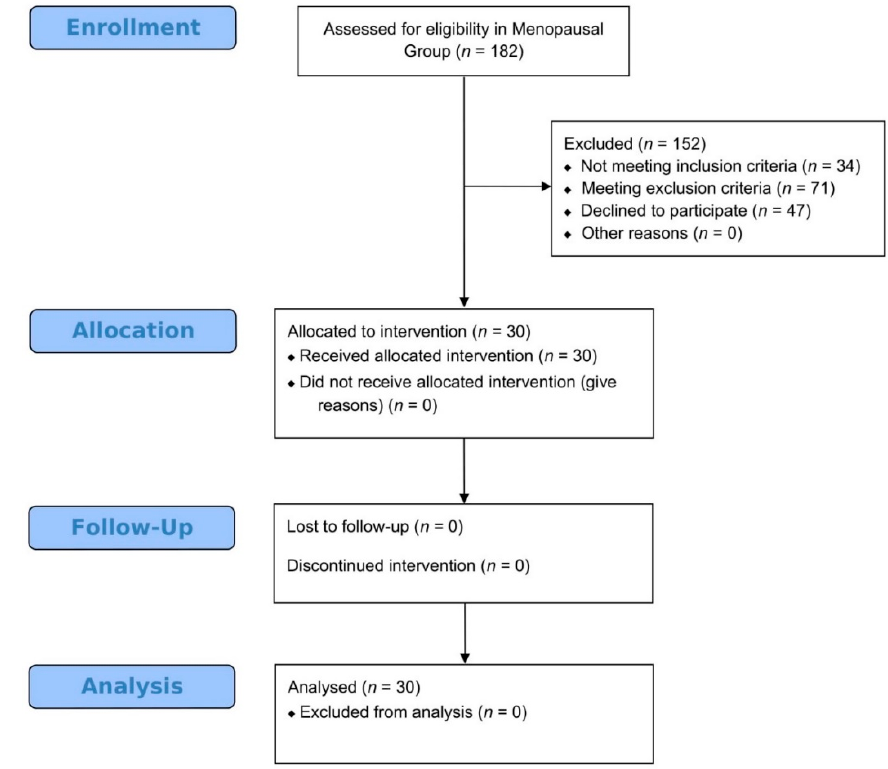
Figure 5. A modified version of CONSORT flow-chart presenting enrollment, allocation, follow-up and analysis of participants regarding the Menopausal pilot study.